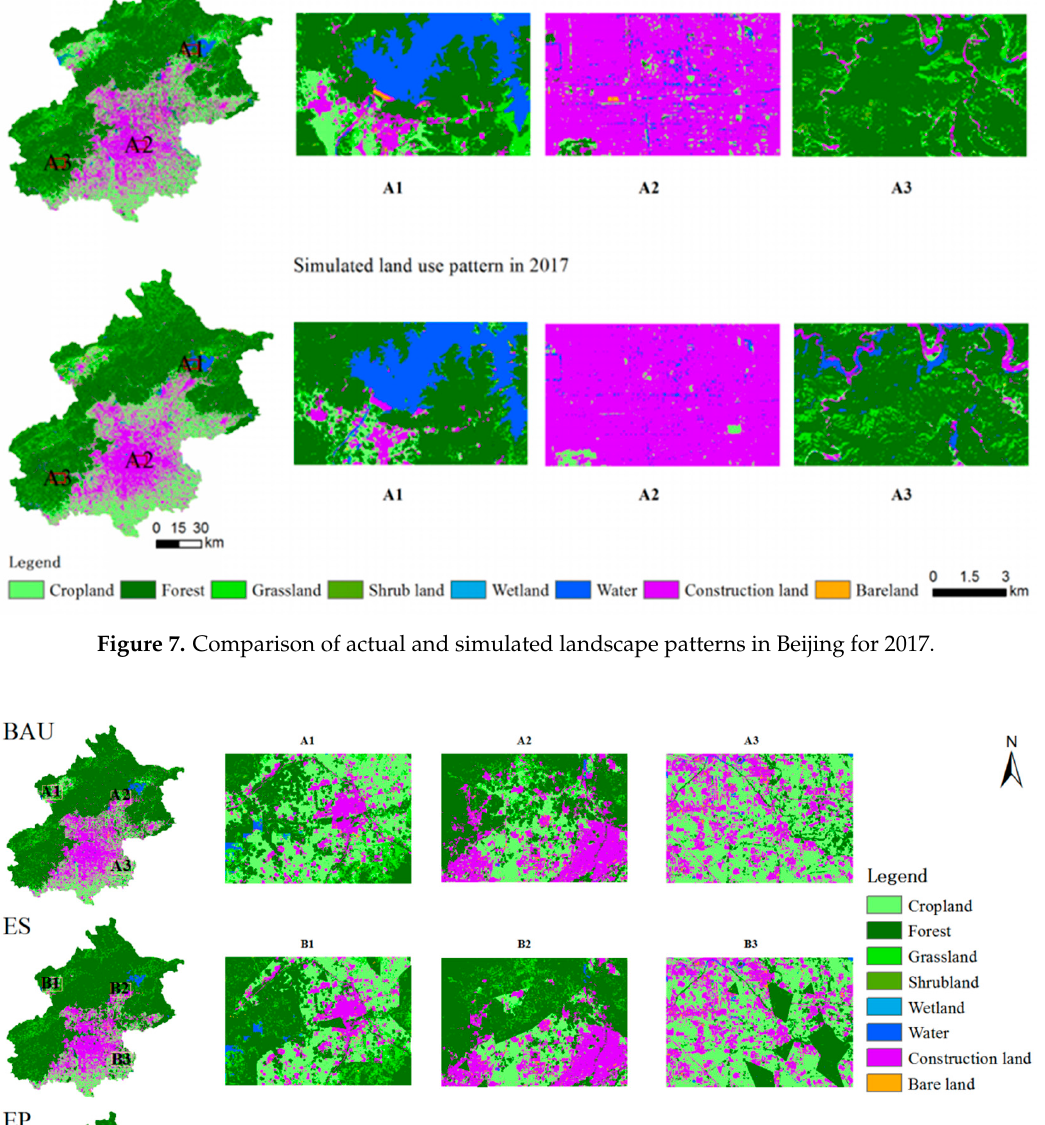
4 of 21 Table 3. Simulated and actual values of landscape types in 2017. Landscape Types